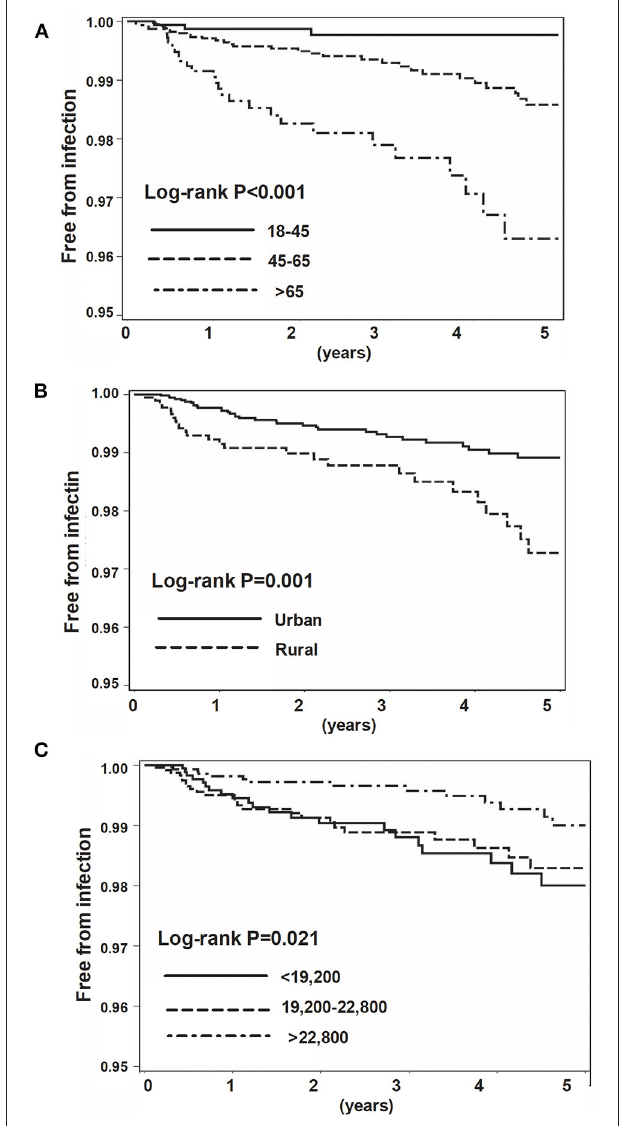
FIGURE 1 | Kaplan–Meier survival curve for incidental hospitalised infection. Categorised by age (A) , urbanisation status (B) , and insured amount (C)